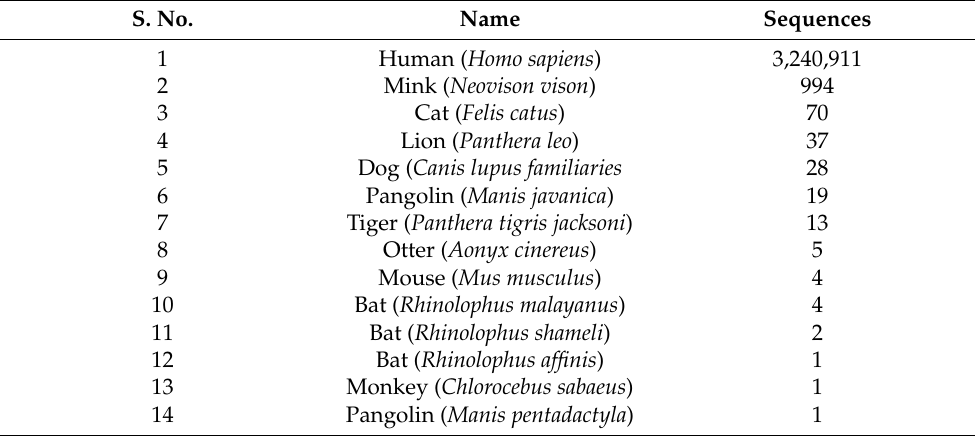
Table 1. SARS-CoV-2 hosts.